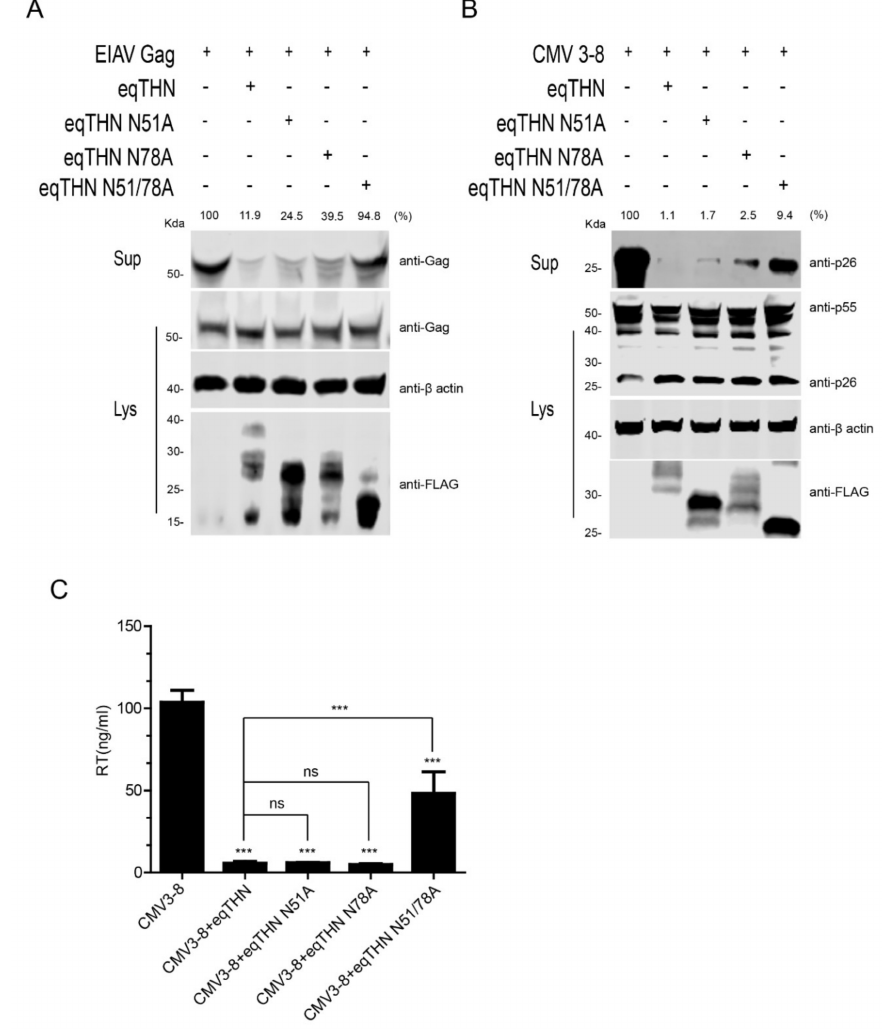
Figure 2. N-glycosylation a ff ects the antiviral activity of eqTHN. ( A ) HEK293T cells were transfected with 1 µ g of EIAV gag and 1 µ g of expression vector carrying either WT eqTHN or one of its N-glycosylation mutants. At 48 h posttransfection, cultured supernatants were ultracentrifuged to concentrate the released Gag protein. Western blotting, using anti-EIAV p26 monoclonal antibody, was used to detect the presence of Gag proteins in the supernatants and cell lysates. ( B ) HEK293T cells were transfected with 1 µ g of infectious EIAV clone (pCMV3-8) and 1 µ g of WT eqTHN or one of its mutants. At 48 h posttransfection, cultured supernatants were ultracentrifuged to concentrate the virion particles. Viral CA protein (p26) in the supernatant and Gag protein (p55) in the cell lysates were analyzed by western blotting using anti-EIAV p26 monoclonal antibody. ( C ) Released virions from HEK293T cells transfected with 1 µ g of pCMV3-8 and 1 µ g of either WT eqTHN or one of its mutants were analyzed by reverse transcriptase (RT) activity at 48 h posttransfection. Virions were analyzed using western blotting to detect viral Gag and CA proteins’ band intensity by Image Studio. Error bars from three independent experiments. *** p < 0.001; ns, not